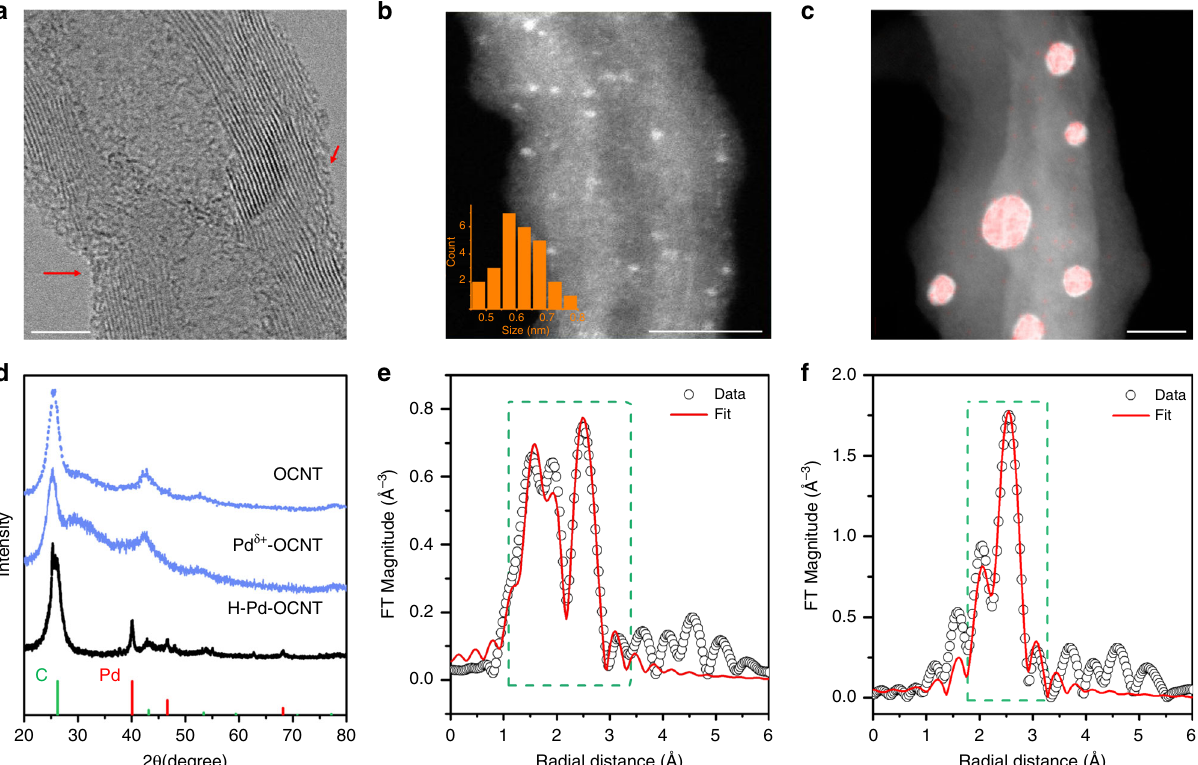
Fig. 1 Structural characterization of Pd δ + -OCNT and H-Pd-OCNT electrocatalysts. a HRTEM and b annular dark- fi eld (ADF)-STEM image of Pd δ + -OCNT presenting uniform distribution of amorphous Pd atom clusters (scale bar: a 5 nm and b 10 nm). Inset fi gure shows the size distribution of the Pd clusters. c EDS element mapping of H-Pd-OCNT shows the formation of aggregated crystalline Pd nanoparticles with size of 3~10 nm (red: Pd and scale bar: 10 nm). d Powder XRD patterns of 6.5 h OCNT, Pd δ + -OCNT and H-Pd-OCNT. Fourier transform EXAFS analysis of Pd K-edge data for Pd δ + -OCNT ( e ) and H-Pd- OCNT ( f